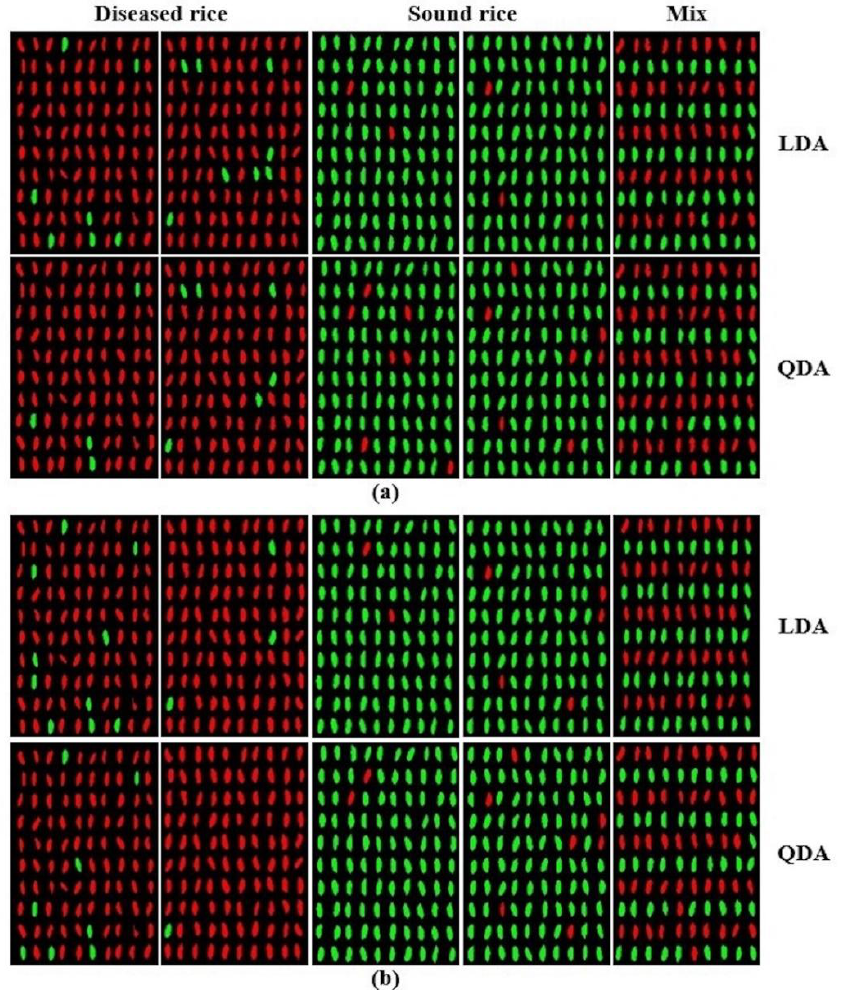
Figure 7. Visualization of classification image with smoothing pretreatment by using ( a ) two and ( b ) three wavelengths. Table 3. Calibration and validation results of each classifier with different pretreatment methods using two subset wavelengths for diseased and sound rice seed.